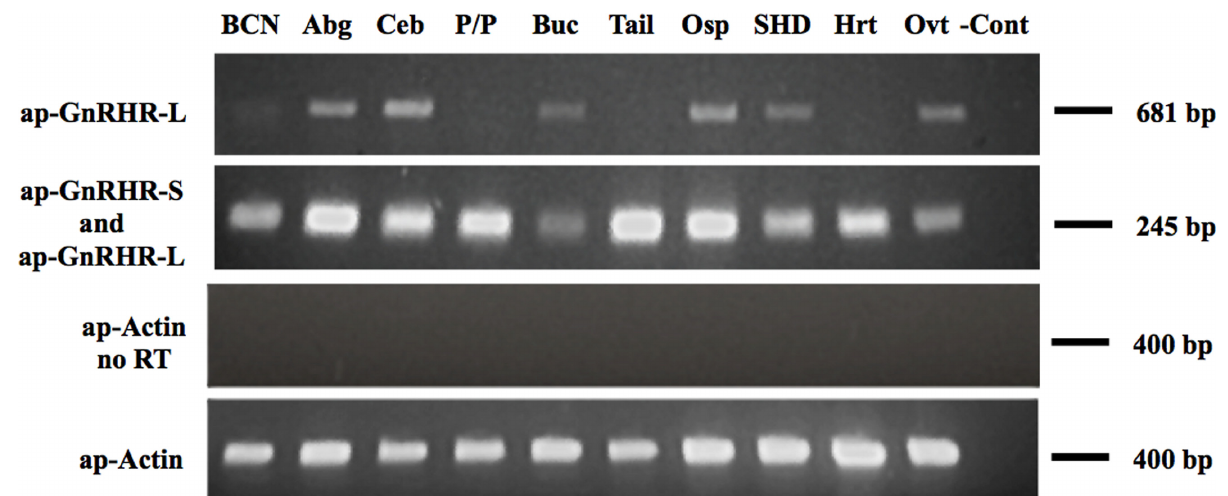
Fig 3. Expression of ap-GnRHR isoforms (top two panels) in different A . californica tissues examined by RT-PCR. Primers used for the top panel amplify only ap-GnRHR-L; primers used for the second panel amplify both ap-GnRHR-L and ap-GnRHR-S. Negative controls (no RT) were RNA samples that have not been reverse transcribed (third panel). ap-Actin was used as a control to ensure the quality of RNA samples (bottom panel). The sizes of the PCR products are shown on the right. BCN, bag cell neurons; Abg, abdominal ganglia; Ceb, cerebral ganglia; P/P, pedal/pleural ganglia; Buc, buccal ganglia; Tail, ventral tail tissue; Osp, osphradium; SHD, small hermaphroditic duct; Hrt, heart; Ovt, ovotestis; — Cont, negative water